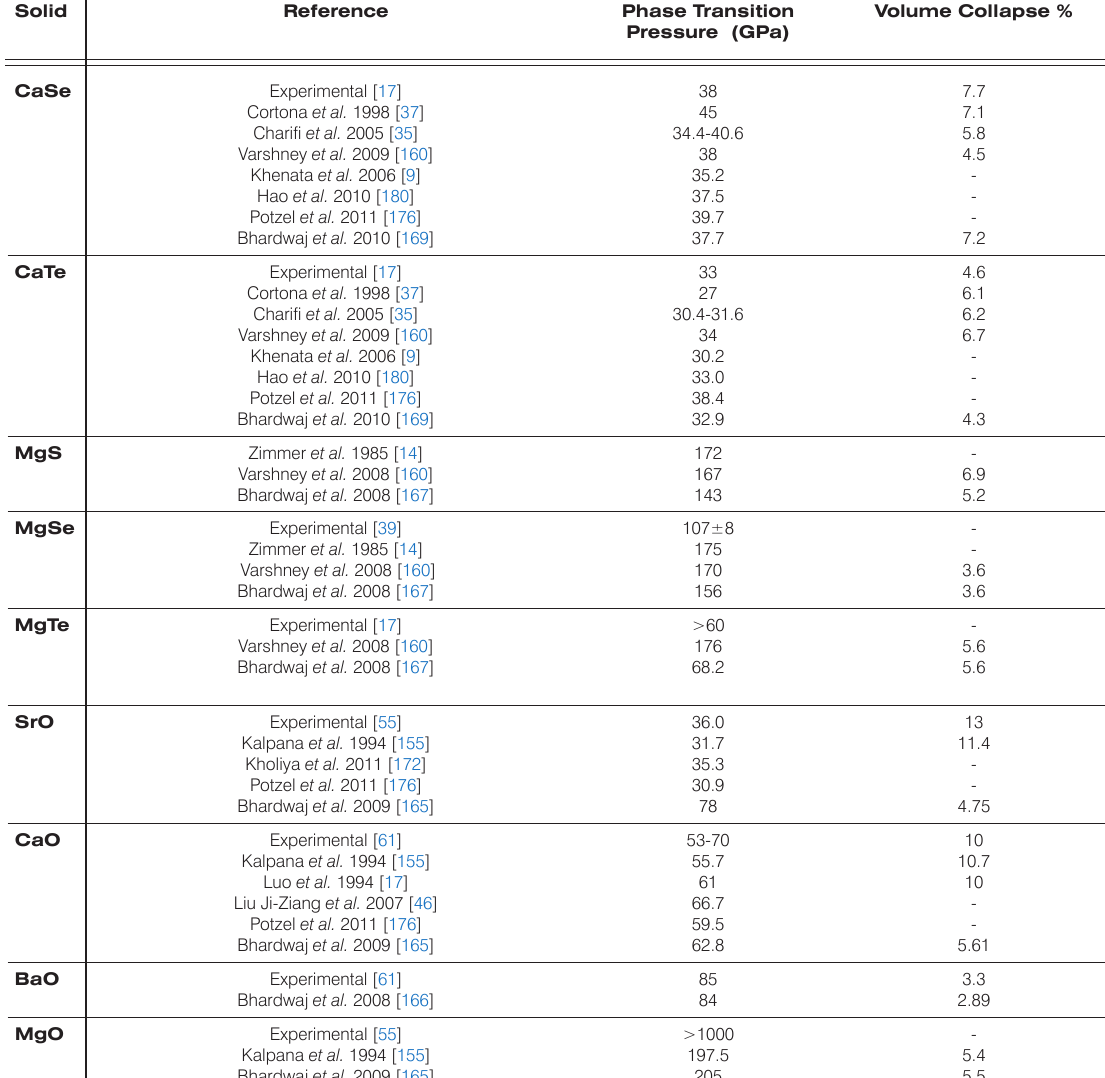
Table 3 and Table 4 respectively for group II-IV alkaline earth chalcogenides. The values given in Tables 2-4 have been calculated by different electronic and model calculations like ab-initio pseudopotential density